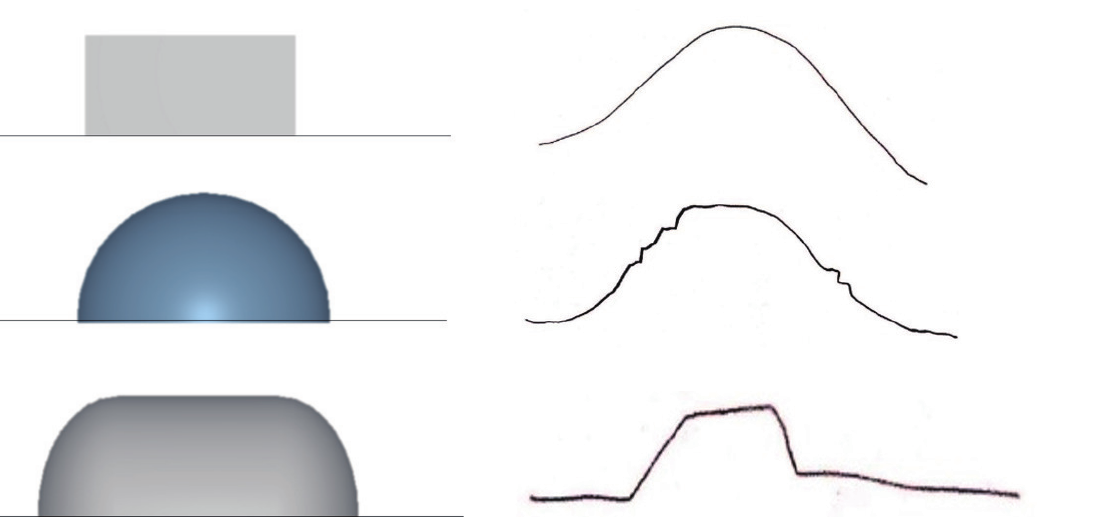
Figure 8. The shapes and participant drawings from the geometry experiment. This experiment was conducted to test the static pressure rendering capabilities of the haptic